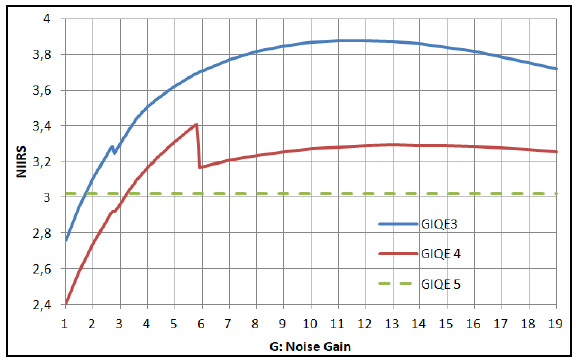
Figure 4: NIIRS for ideal Q = 1 system with SDNR = 30